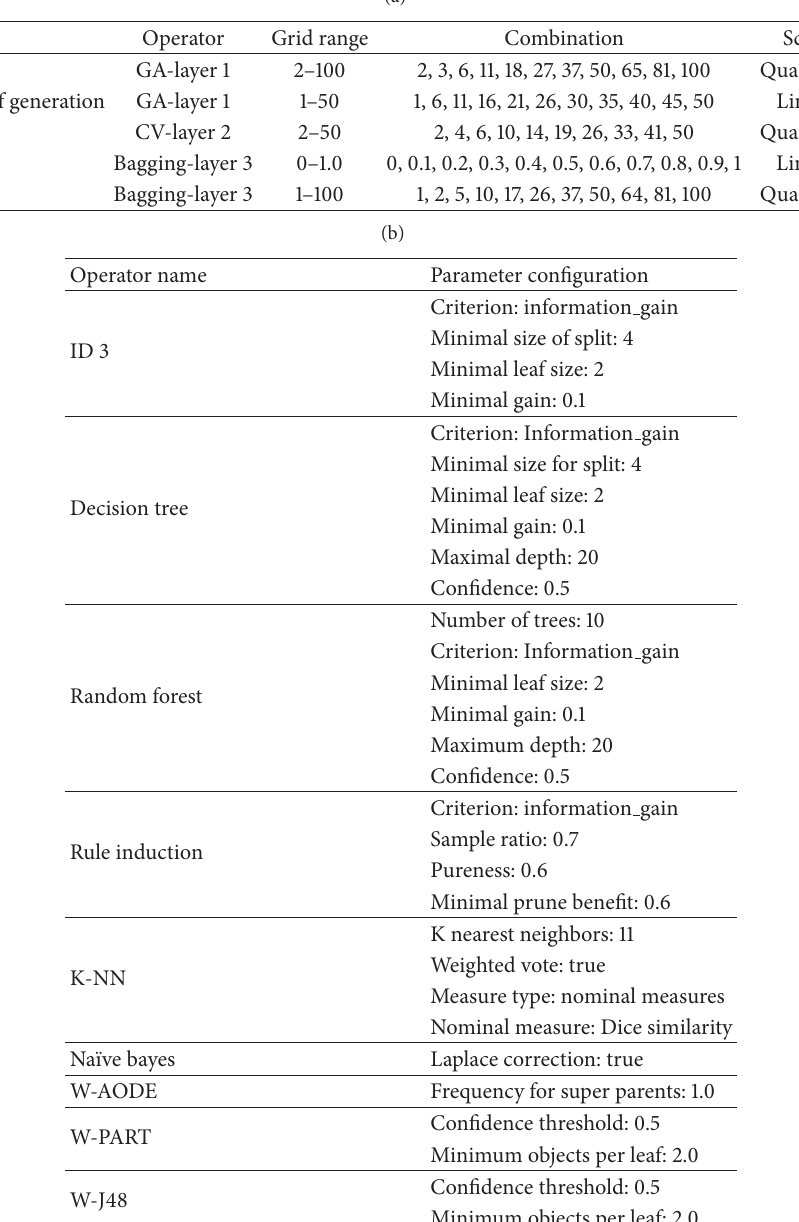
Table 2: (a) Parameter optimization using grid search. (b) Parameter configuration for